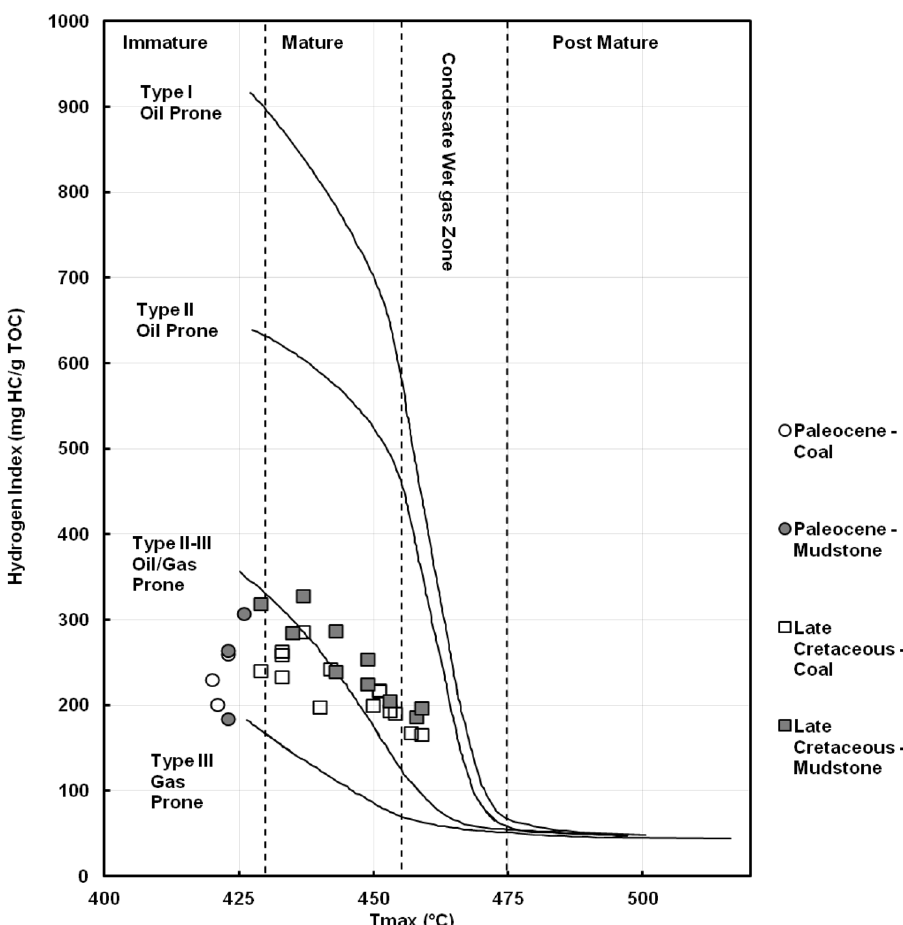
Fig. 7 A cross-plot of hydrogen index (HI) versus maximum pyrolysis temperature ( T max ) to indicate source rock